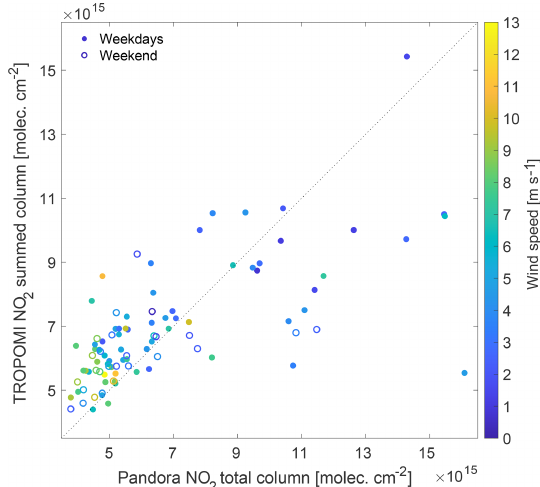
Figure 3. Scatterplot of Pandora and TROPOMI vertical columns. The filled dots correspond to weekdays while the empty circles to the weekends. The colour indicates the wind speed interpolated at the overpass time. The 1 : 1 line is plotted as a dotted line.